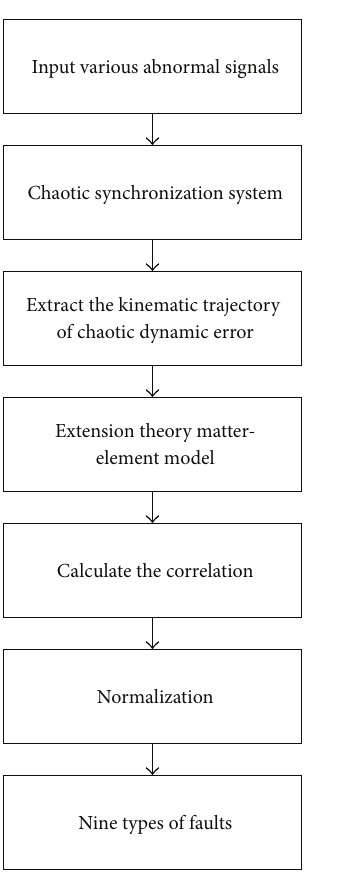
Figure 2: Chaotic signal synchronization and extension diagnostic system flow chart.